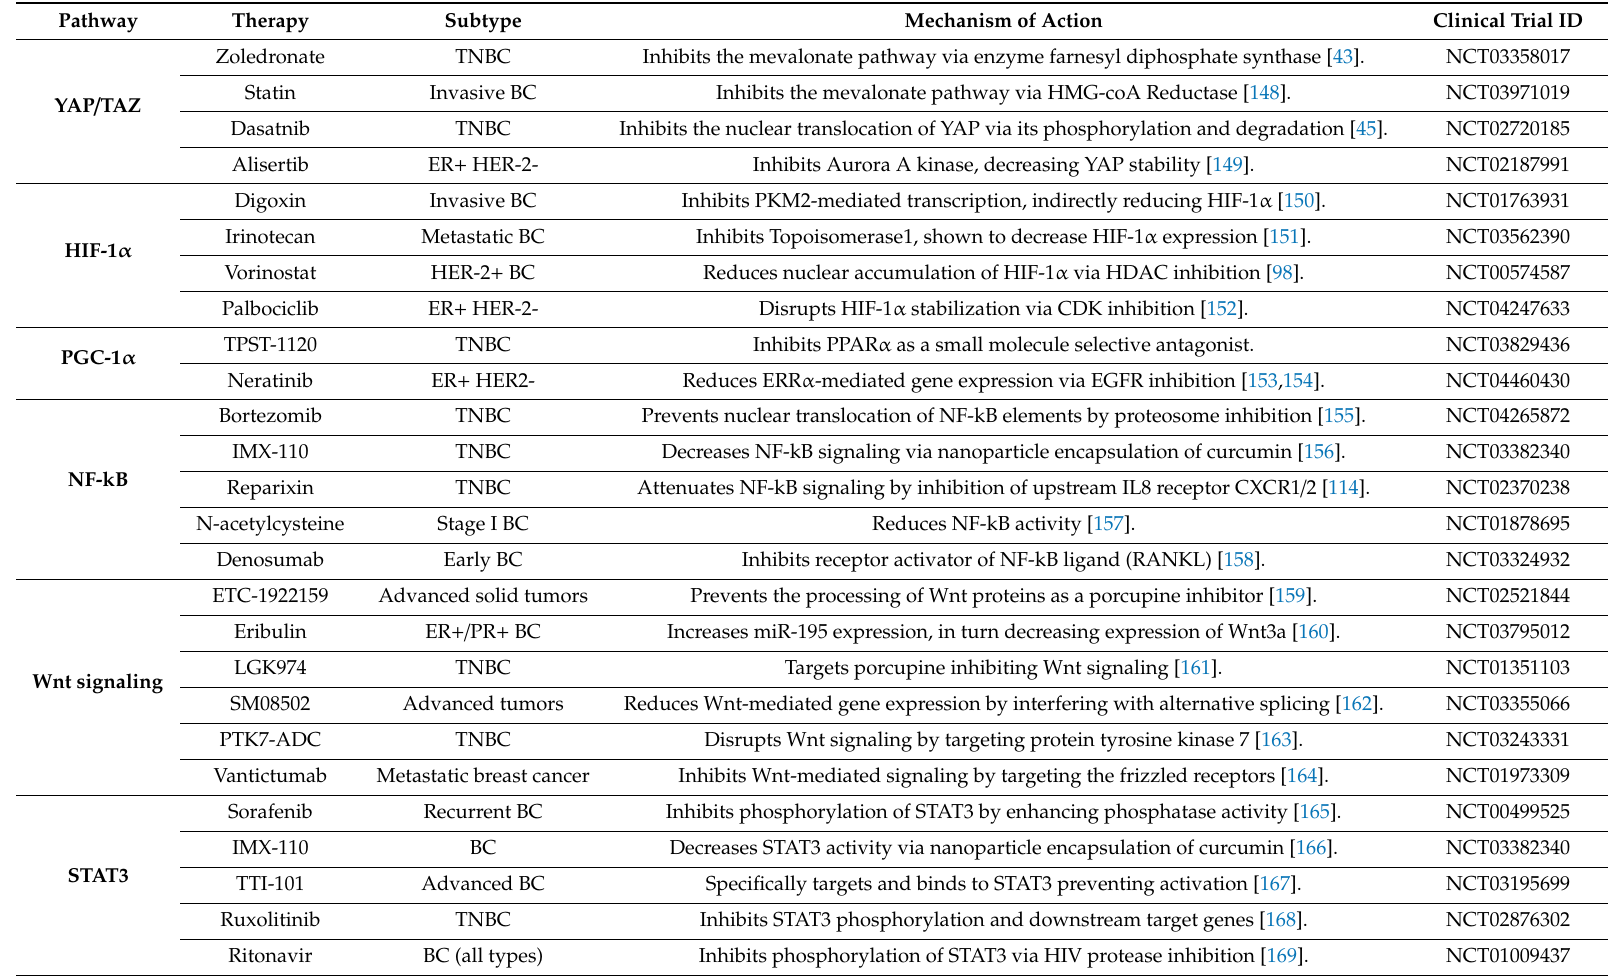
Table 1. Potential therapeutic strategies investigated in recent clinical trials for the treatment of breast